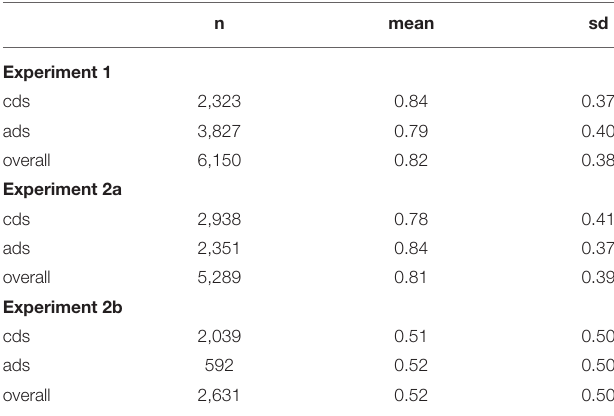
TABLE 2 | The Experiment 1 counts, means, and standard deviations for Accuracy broken out by cds, ads, and overall